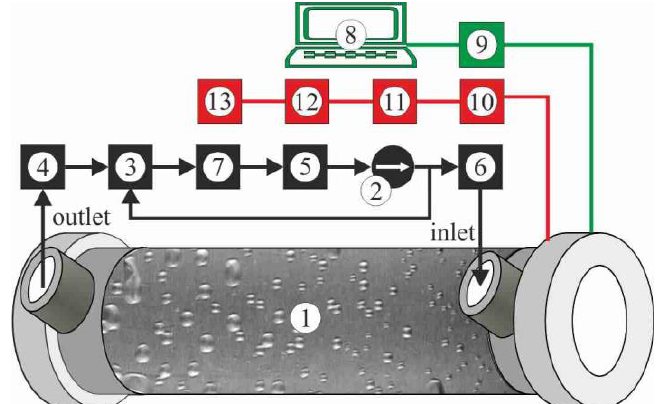
Figure 1. The schematic diagram of main loops realized in the experimental stand: 1—a test section, 2—a gear pump, 3—a compensating tank, 4—a tube-type heat exchanger, 5—a filter, 6—a mass flow meter, 7—a deaerator, 8—a data acquisition station, 9—a pc computer, 10—an ammeter, 11—a voltmeter,